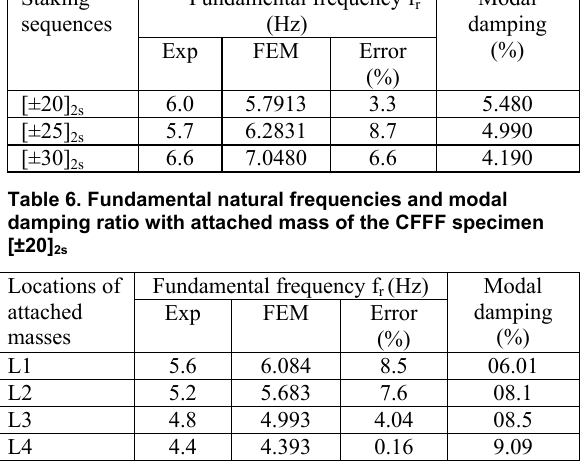
Table 7. Fundamental natural frequencies and modal damping ratio with attached mass of the CFFF specimen